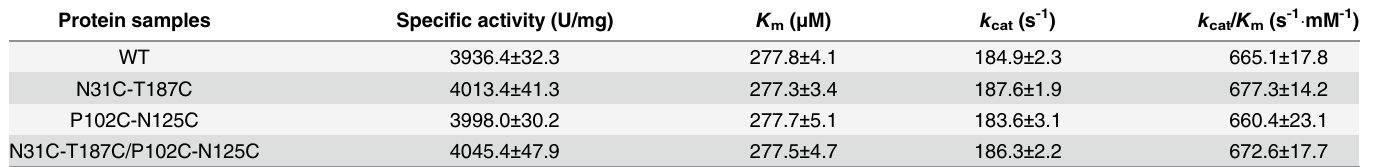
Table 4. Kinetic parameters of wild-type BglTM and the mutants. Protein